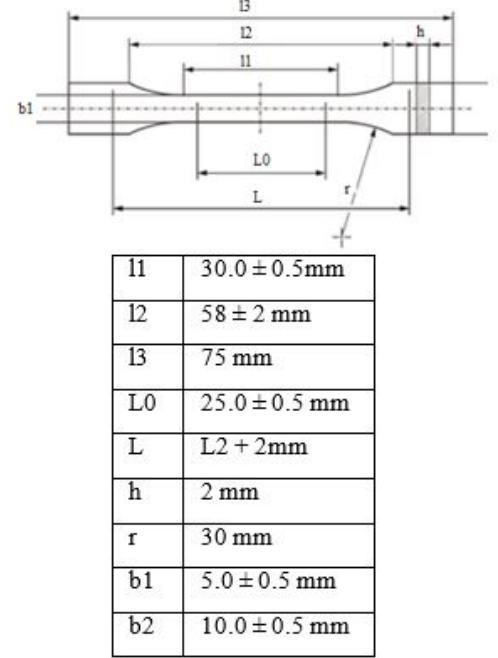
Figure 2. Specimen dimensions according to DIN EN ISO